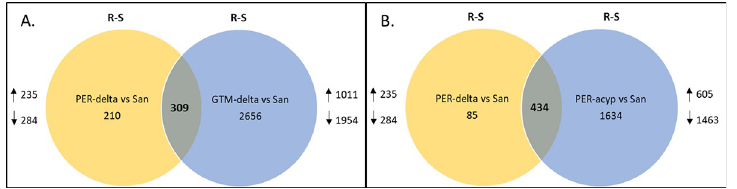
Fig 5. The Venn diagrams summarizing differentially expressed genes with a transcription ratio � 2 fold change in either direction and a corrected p value < 0.05 between A.) Deltamethrin resistant samples from Peru and Guatemala; B.) Deltamethrin and alpha-cypermethrin resistant samples from Peru.